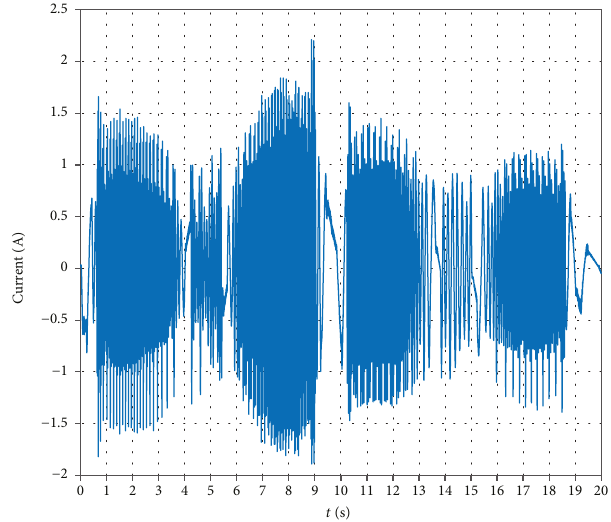
Figure 28: The working currents of the motor for the Varus/valgus rehabilitation motion (from -10 ° to +10 ° ).